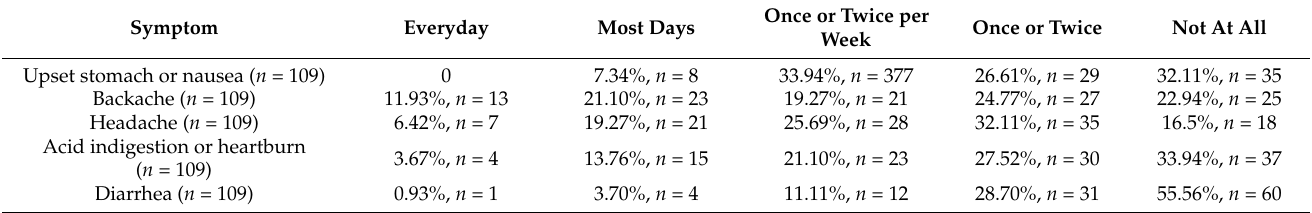
Table 4. Physical symptoms reported by emergency department workers during the COVID-19